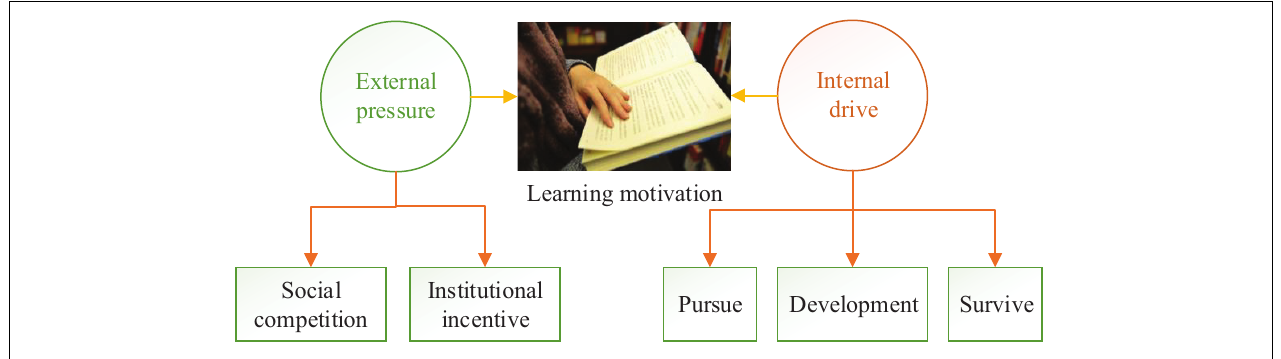
FIGURE 1 | The generation mechanism of learning motivation of